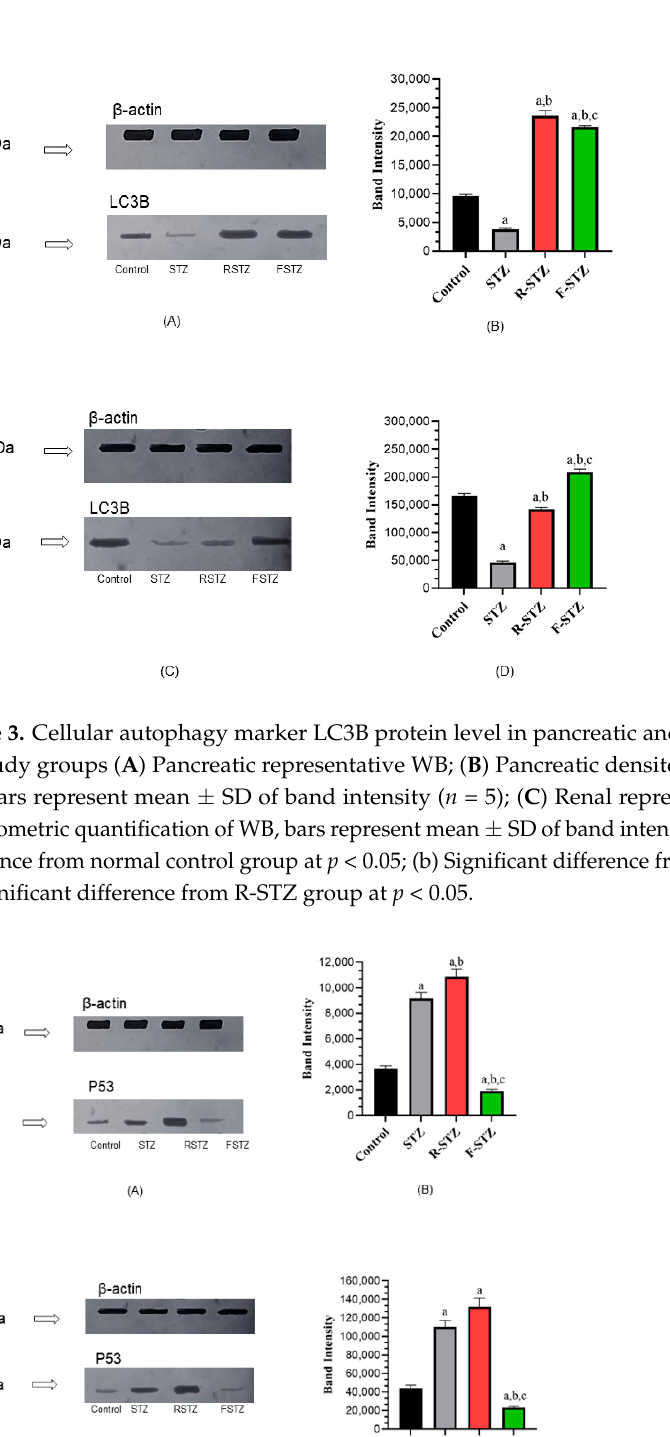
Figure 4. Cellular apoptosis marker p53 protein level in pancreatic and renal tissue samples of the study groups ( A ) Pan- creatic representative WB; ( B ) Pancreatic densitometric quantification of WB, bars represent mean ±SD of band intensity ( n = 5); ( C ) Renal representative WB; ( D ) Renal densitometric quantification of WB, bars represent mean ±SD of band intensity ( n = 5). (a) Significant difference from normal control group at p < 0.05; (b) Significant difference from STZ group at p < 0.05; (c) Significant difference from R-STZ group at p <